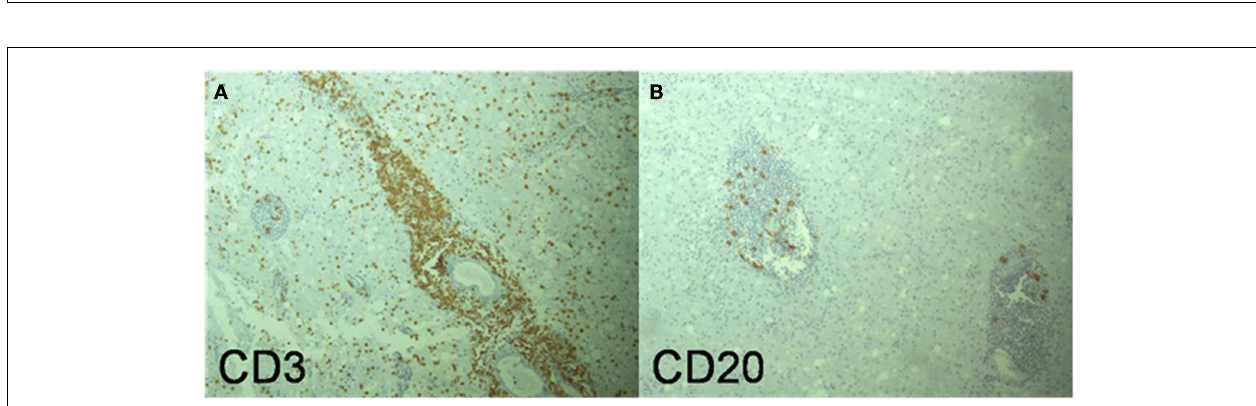
FIGURE 3 | (A,B) (Low and medium power magnification) Primarily perivascular inflammatory infiltrates with secondary lymphocytic infiltrates in the parenchyma. (C) (High power) of white matter perivascular lymphocytic infiltrates. (D) (Low power) of perivascular and parenchymal infiltrates in the superficial cortex and leptomeninges.